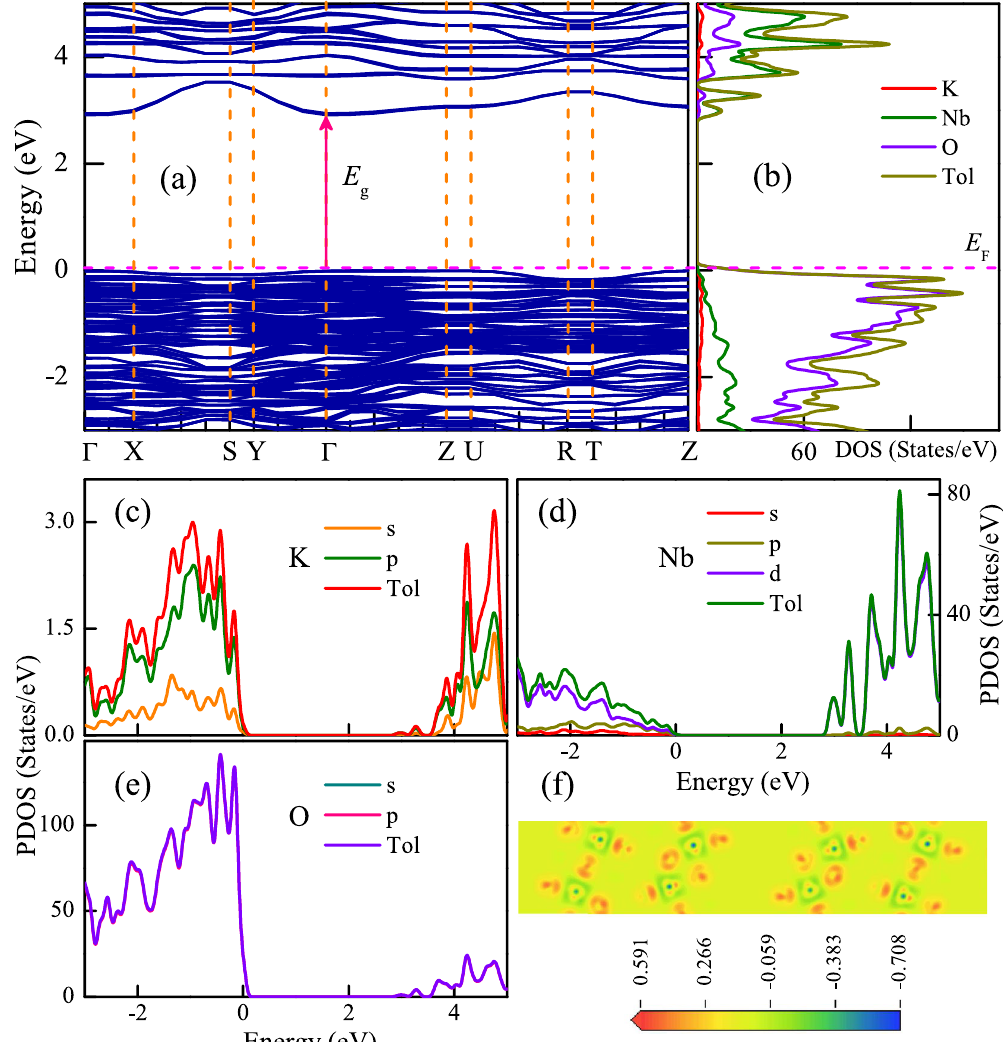
Figure 8. ( a ) Calculated band structure and ( b ) corresponding density of states for KN, where E F denotes the Fermi energy level. Note that the solid arrow located at the point of symmetry Γ indicates the direct electron transitions of optical band gap. Partial density of states for ( c ) K, ( d ) Nb and ( e ) O elements, respectively. ( f ) Charge density difference of